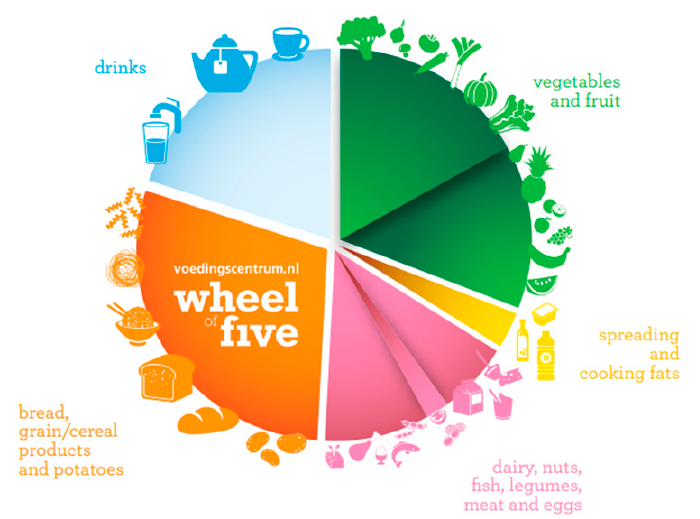
Figure 1. Wheel of Five of the Netherlands